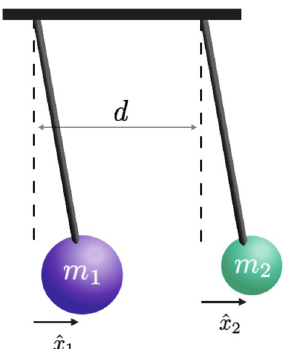
Figure 1. System: two suspended masses (pendula) m 1 and m 2 , where x j is the displacement of the j th mass from the respective equlibrium position and d the distance between the equilibrium